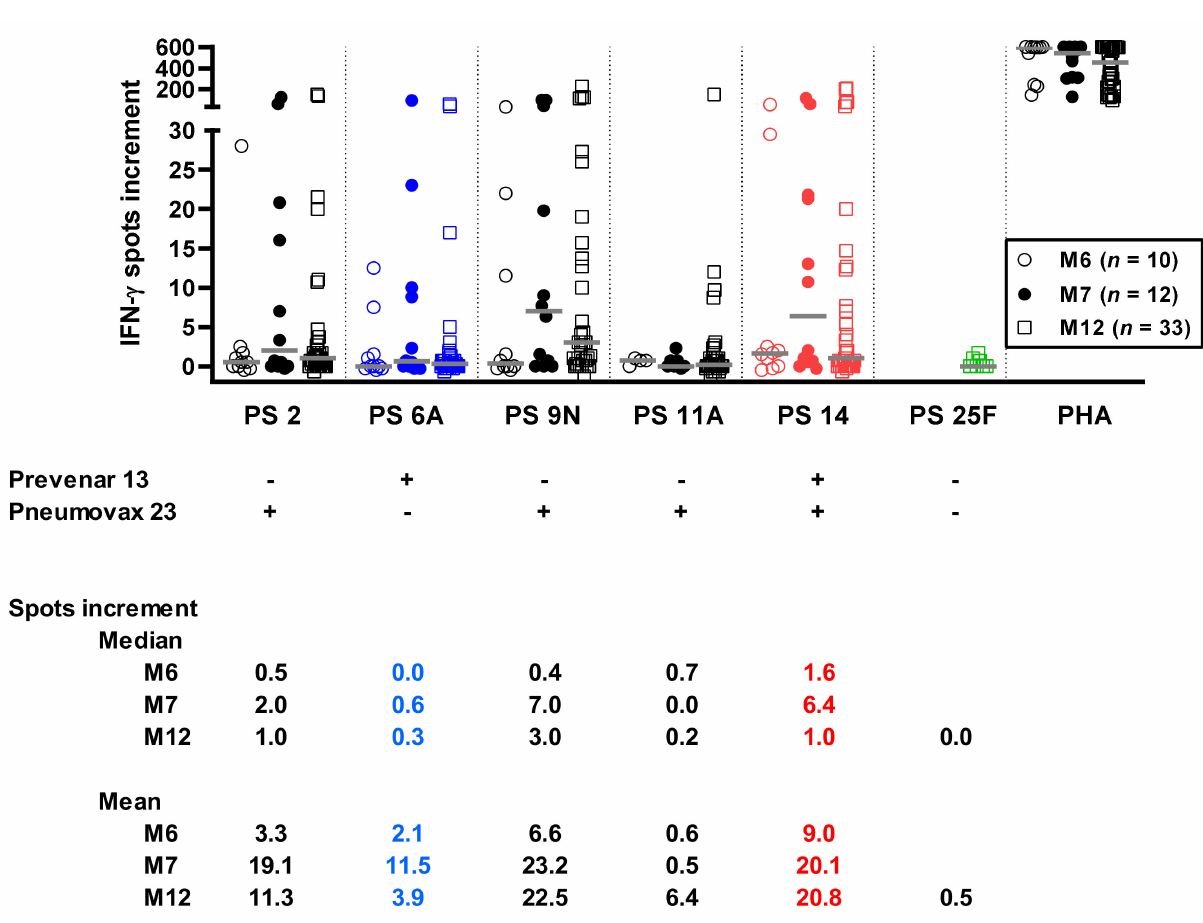
Figure 3. Specific cellular immunity against S. pneumoniae in kidney transplant recipients after having received vaccination with Prevenar 13 (month (M) 6) or Prevenar 13 and Pneumovax 23 (M7 and M12). Of note, we chose pneumococcal serotypes (PS) contained only in the vaccine Prevenar 13 (6A, blue), only in Pneumovax 23 (2, 9N, 11A, black), in both vaccines (14, red), or in none of them (25F, green). Responses towards PS 14 were measured only in 41 out of 55 samples, and responses towards PS 25F were measured only in seven (at M12). We used median values for the three concentrations of each polysaccharide (100, 150, and 200 µ g/mL), yielding a single result per sample and time point. Median values are indicated by grey horizontal lines. Positive control experiments were performed with the T-cell mitogen phytohemagglutinin (PHA). Increment means that negative controls were subtracted from results after stimulation with S. pneumoniae